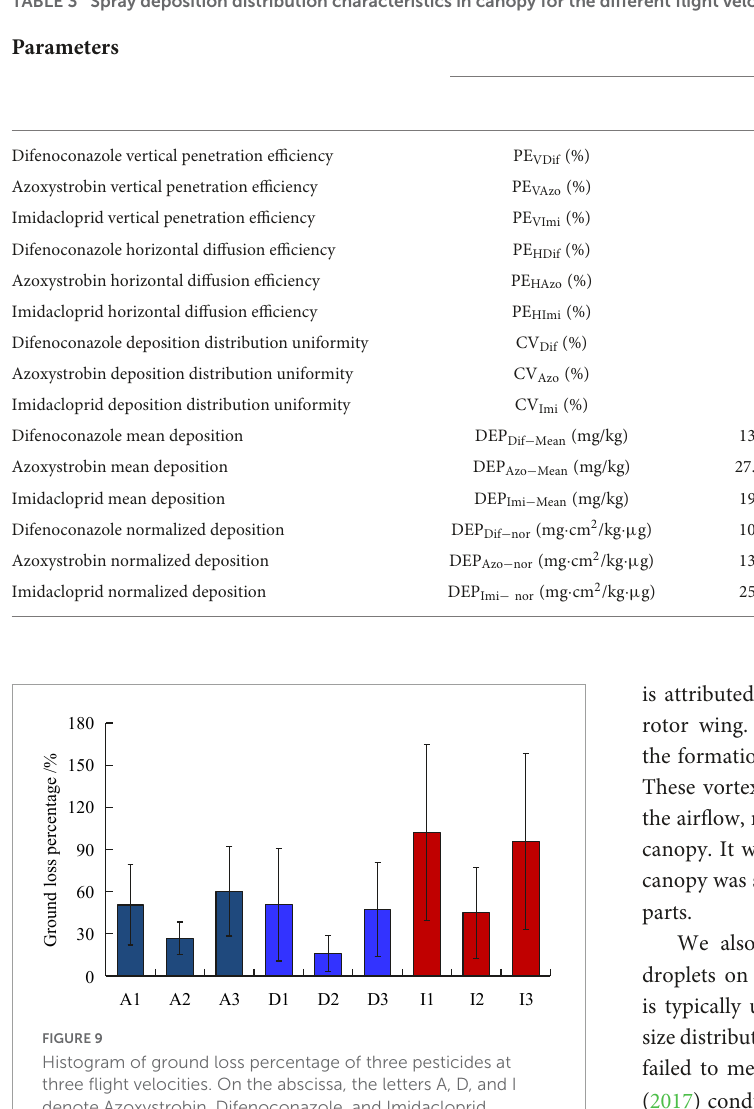
FIGURE9 Histogram of ground loss percentage of three pesticides at three flight velocities. On the abscissa, the letters A, D, and I denote Azoxystrobin, Difenoconazole, and Imidacloprid, respectively. The numbers 1, 2, and 3 denote the flight velocity of 1, 2, and 3 m/s,